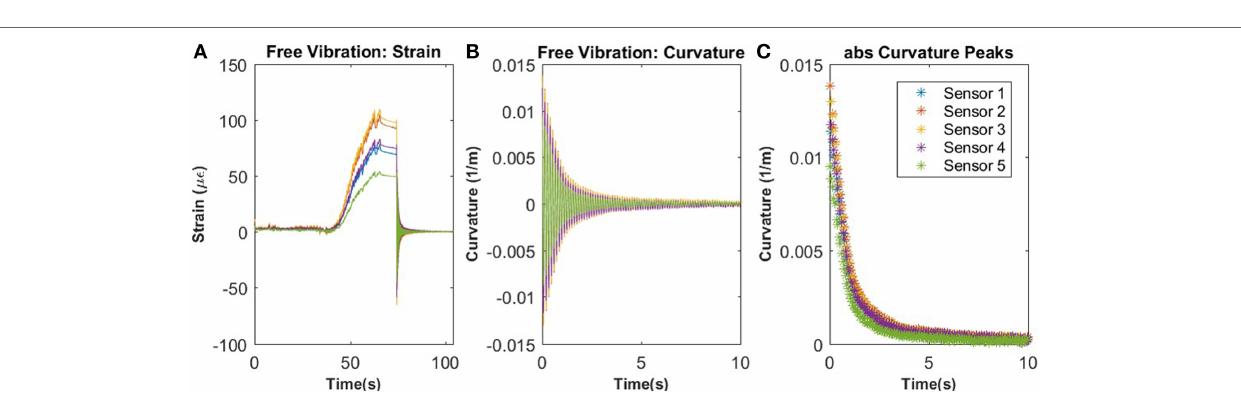
FIGURE 8 | Typical strain and curvature response of aluminum beam during testing: (A) strain response of beam with the initial reference period, followed by the loading of the beam and last the free vibration of the beam; (B) the curvature of the beam during free vibration; (C) the peak curvature values used for analysis of the